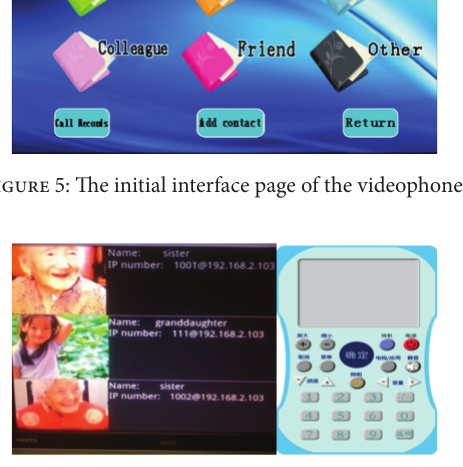
Figure 6: Photo-based Address book (left) and the wireless remote controller